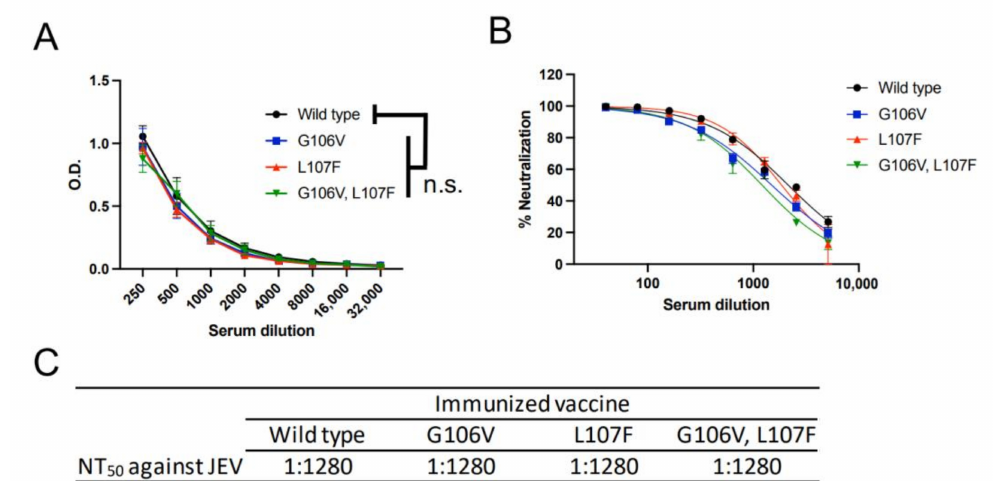
Figure 2. Evaluation of anti-JEV antibodies induced by JE vaccines. ( A ) Comparison of antibody induction using ELISA. JEV was coated onto the ELISA plate. Serially diluted serum samples were used as detector antibodies. A two-way analysis of variance was performed to analyze the sta- tistical significance of the comparison between wild-type and mutant vaccines. p values of <0.05 were considered statistically significant. n.s., not significant. ( B ) Comparison of neutralizing ac- tivity against JEV. ( C ) NT 50 values against JEV. NT 50 is calculated as a maximum serum dilution yielding >50%